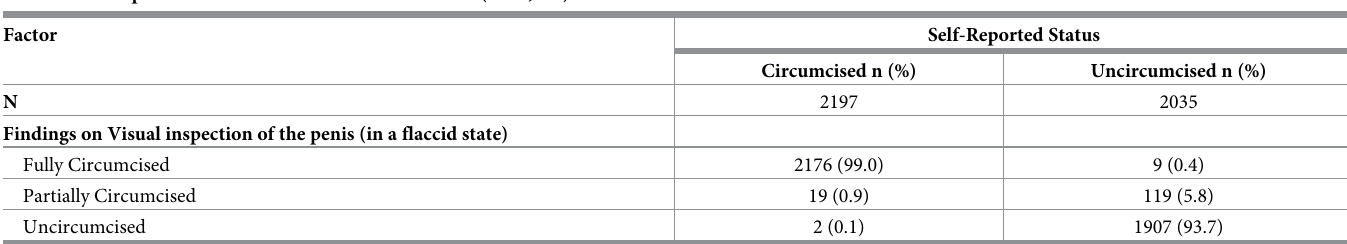
Table 2. Self-reported versus verified circumcision status (n = 4,232).